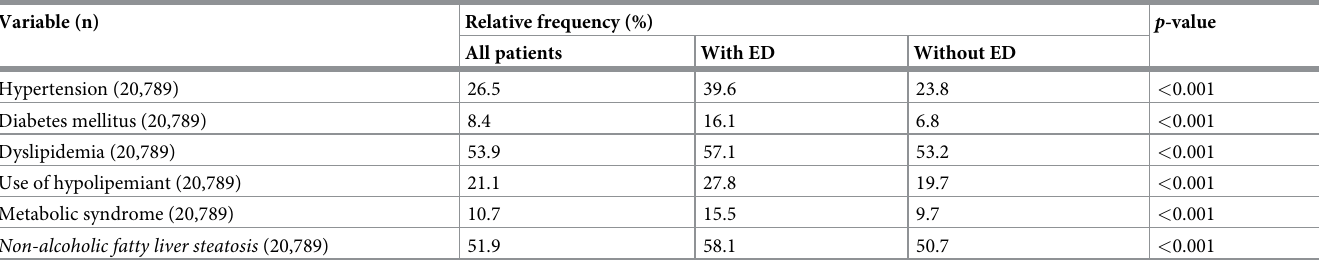
Table 2. Relative frequencies (%) of comorbidities in relation to ED (n = 20,789). Variable (n) Relative frequency (%) p -value All patients With ED Without ED Hypertension (20,789) 26.5 39.6 23.8 <